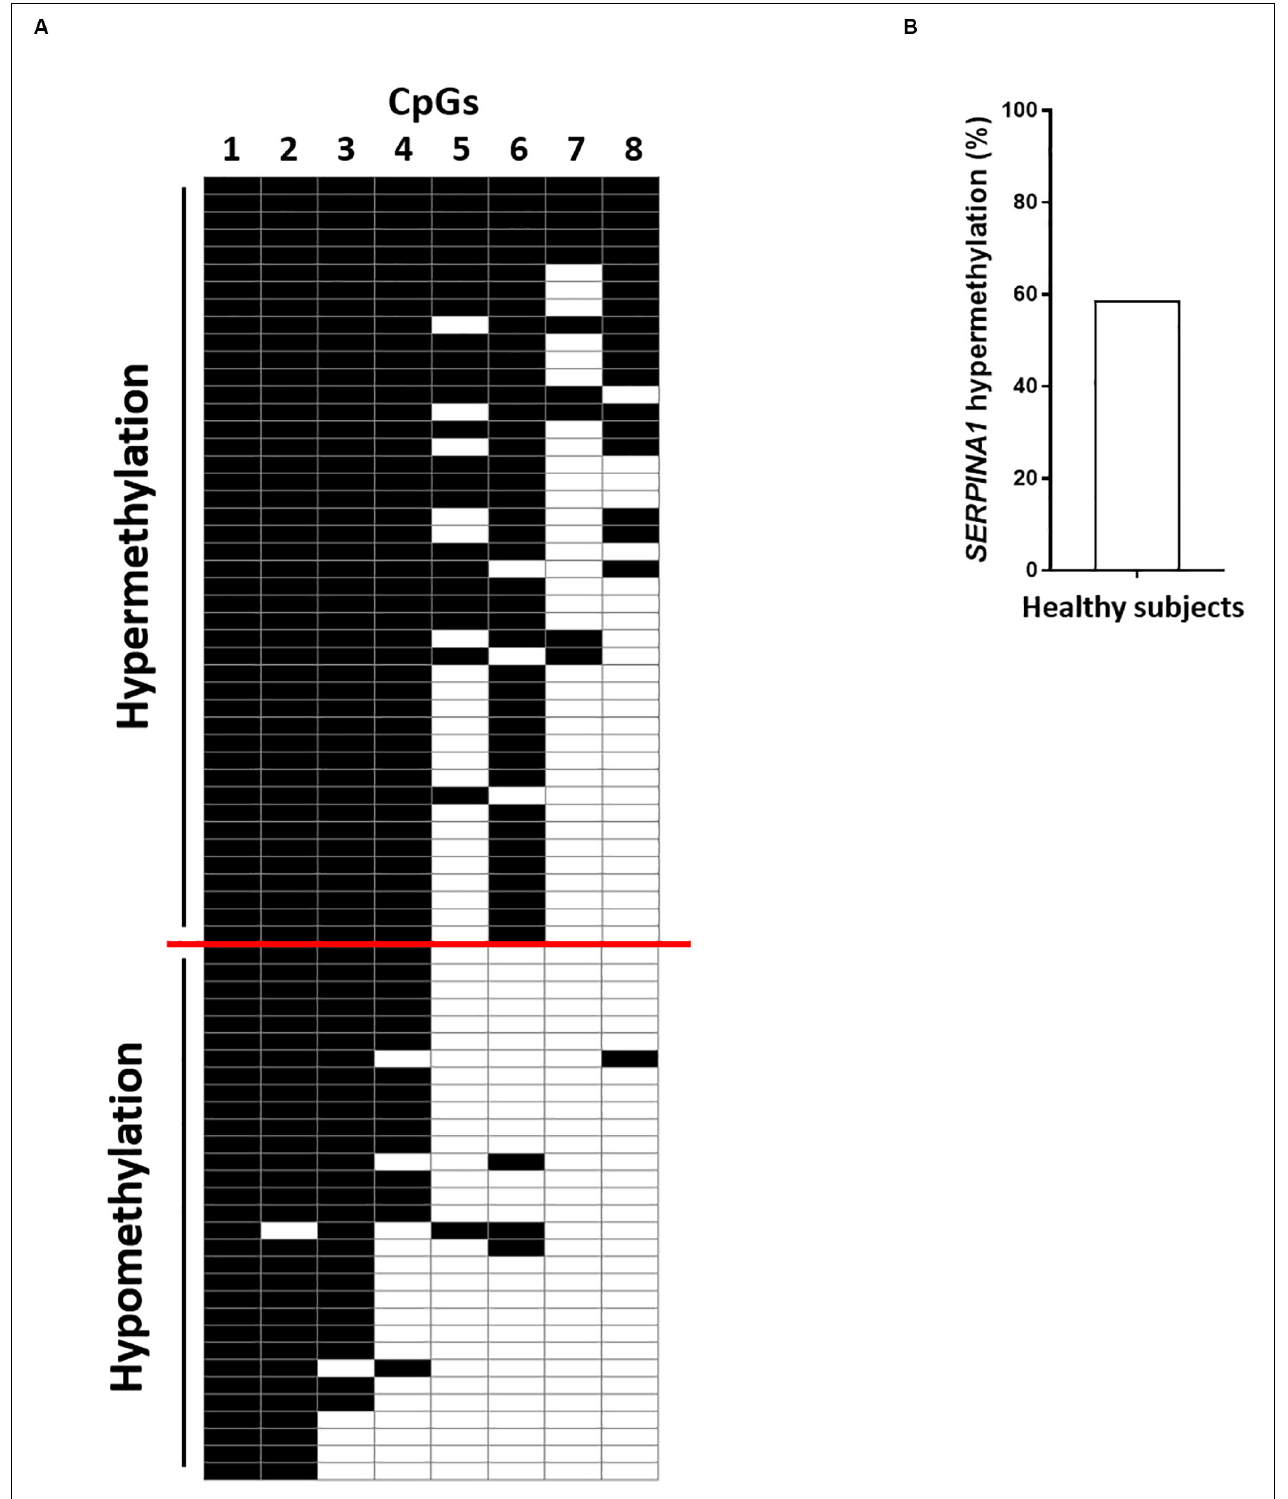
FIGURE 1 | SERPINA1 gene promoter methylation analysis in healthy subjects (HS). (A) HS ( n = 75) stratification according to the number of CpGs methylated (from top to bottom) in SERPINA1 gene promoter, i.e., hypermethylation and hypomethylation. Black boxes represent CpG methylation and white boxes CpG unmethylation. The CpGs within the SERPINA1 promoter are numbered across the top of the grid. Each row represents one sample analyzed by sequencing. Samples were considered hypermethylated when ≥ 5/8 CpGs ( ≥ 50%) were methylated. (B) Frequency of SERPINA1 gene promoter hypermethylation in HS ( N = 75).